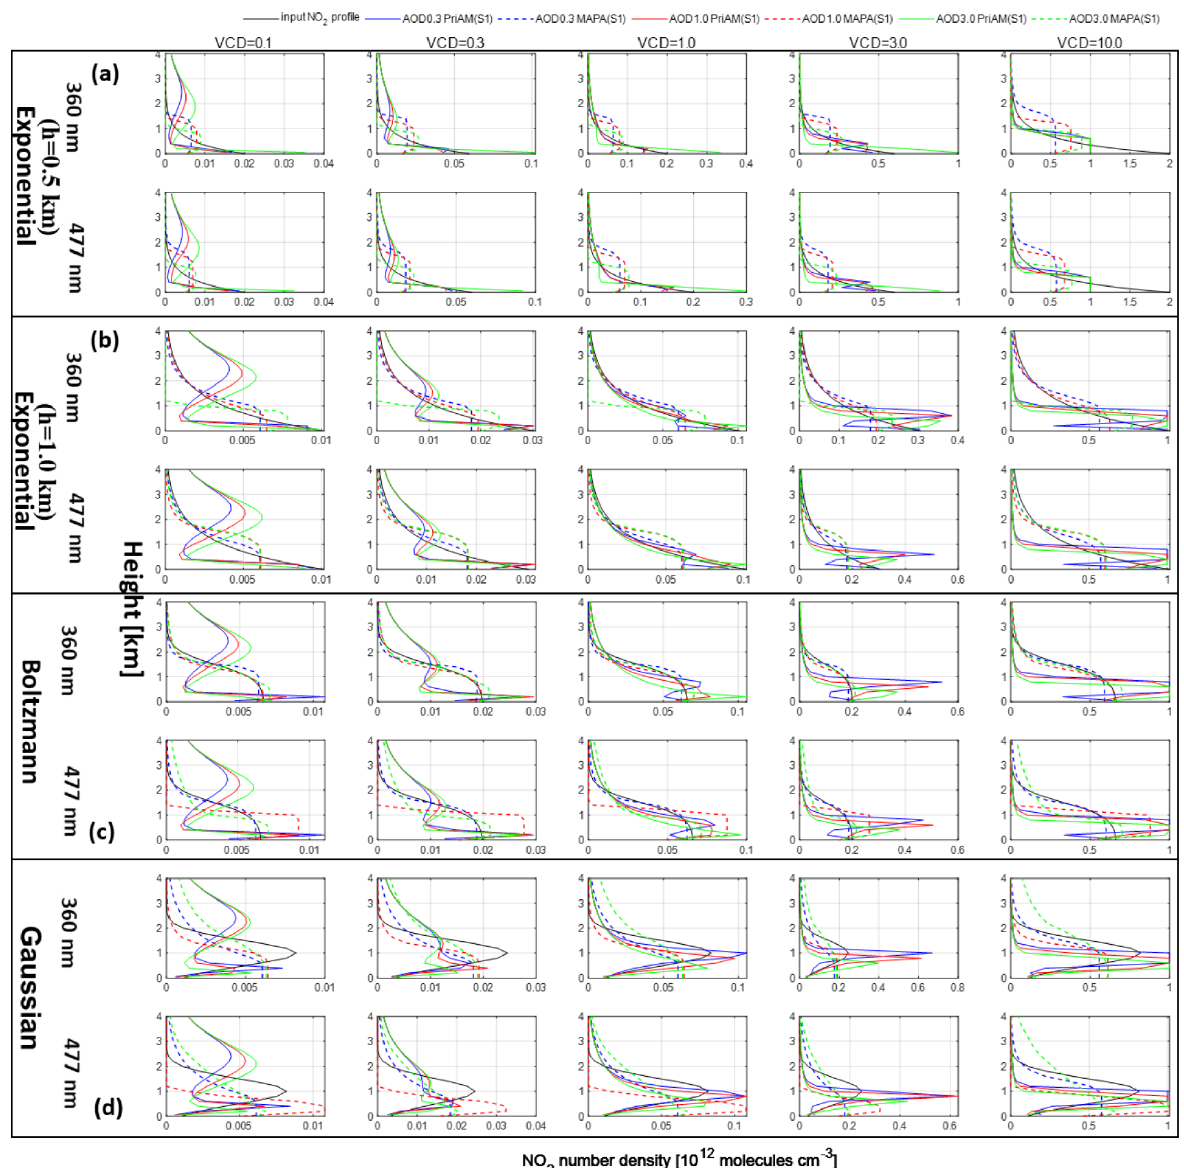
Figure 12. Retrieved NO 2 profiles by PriAM and MAPA for Boltzmann NO 2 input profiles for scenario S1 (see text) and for three aerosol profile shapes ( a exponential shape with h = 0.5km, b exponential shape with h = 1.0km, c Boltzmann shape, and d Gaussian shape) with three selected AODs (0.3, 1.0, and 3.0) and five NO 2 VCDs. The solid and dotted colored lines refer to the AODs and algorithms shown at the